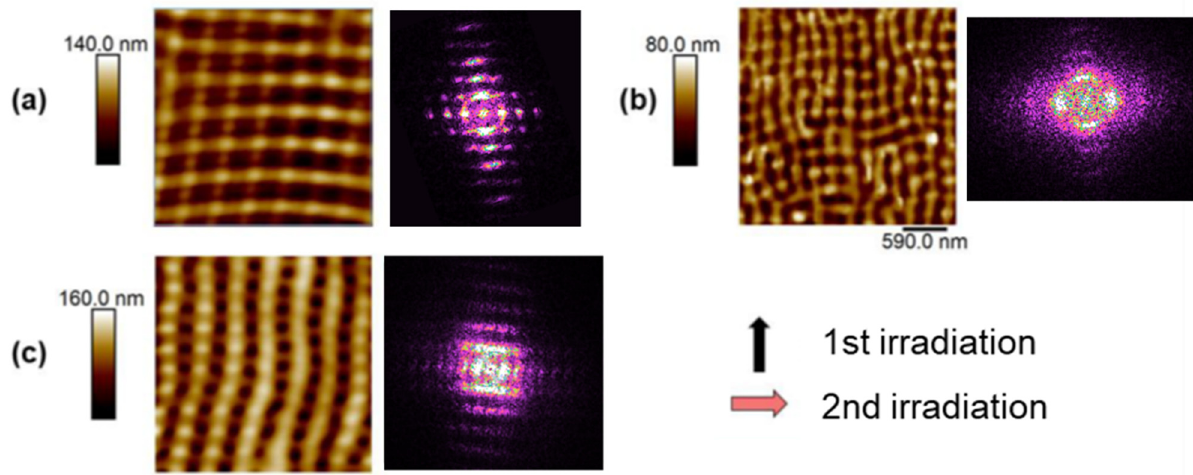
Figure 1. AFM images of combined LIPSS structures formed by sequential irradiation in P3HT. Each AFM image is complemented with its corresponding Fast Fourier Transform (FFT) pattern. ( a ) Sequential irradiation process at λ = 532 nm, 3500 pulses and λ = 532 nm, 100 pulses with the polarization rotated 90°, ( b ) λ = 266 nm, 3300 pulses and λ = 266 nm 300 pulses with the polarization rotated 90° and ( c ) 532 nm, 3600 pulses and λ = 266 nm 300 pulses with the polarization rotated 90°. Arrows indicate the direction of the laser polarization during each irradiation step.